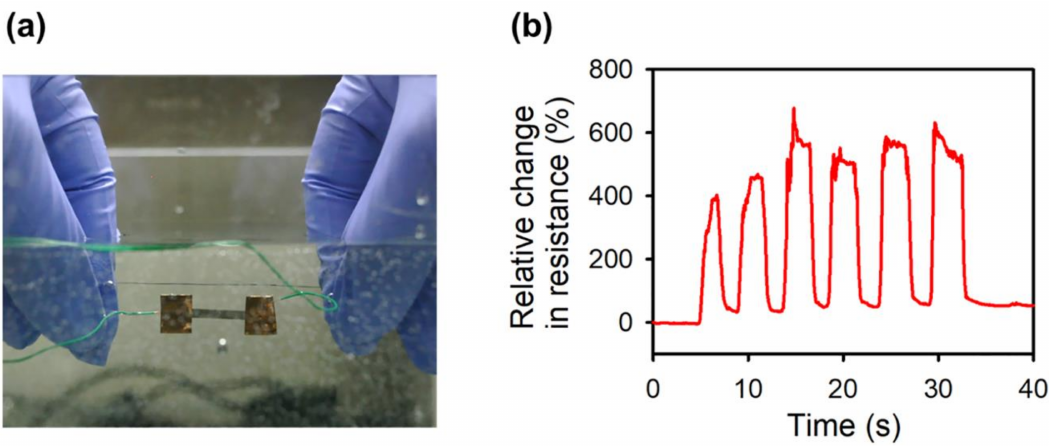
Figure 7. Underwater strain sensing test of the PDMS-shielded waterproof OPSS sensor. ( a ) Optical image of the underwater testing environment; ( b ) manually applied strain sensing test results for 6 strain